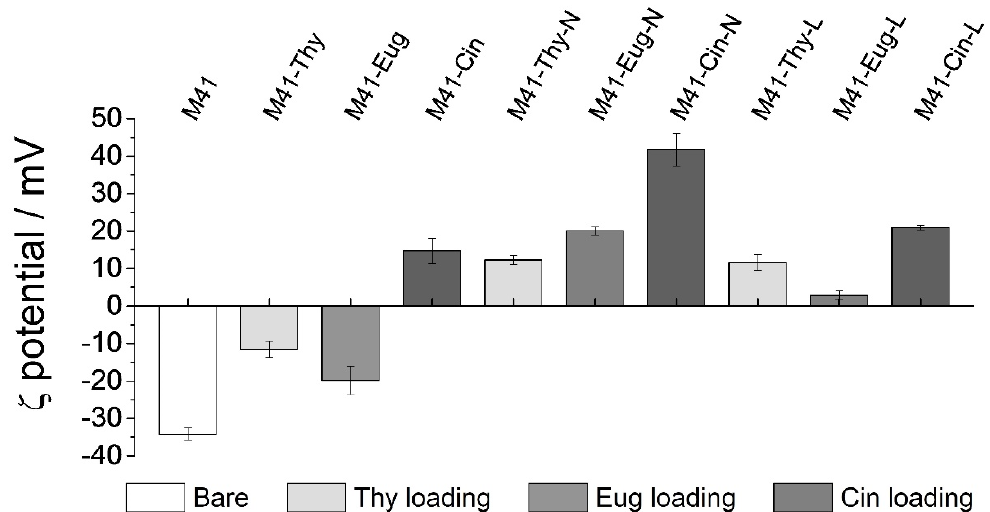
Figure 3. ζ potential values for solids in the different synthesis-stages. From left to right, bare material (M41), loaded supports (M41-EOC), APTES-functionalized materials (M41-EOC-N) and final gated microdevices (M41-EOC-L).